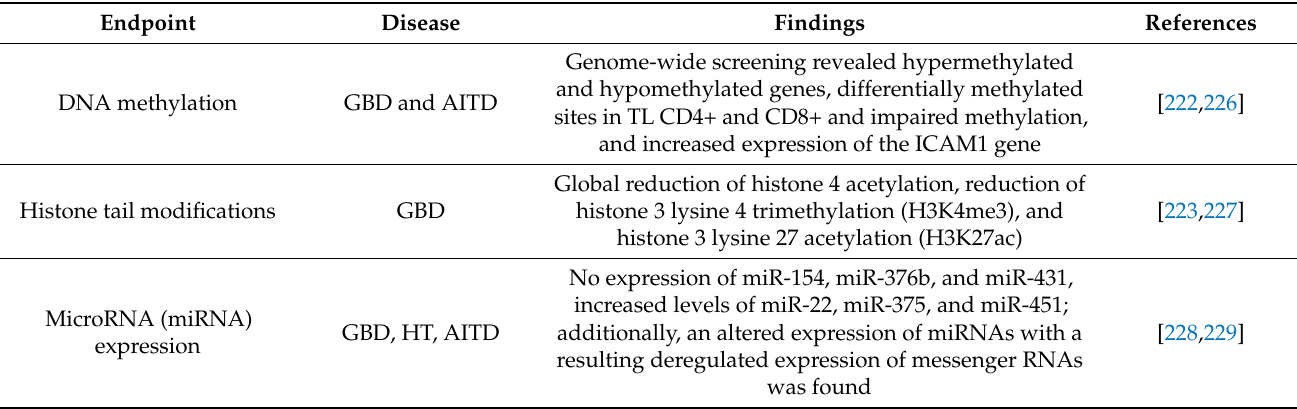
Table 5. Epigenetic studies and general findings in patients with